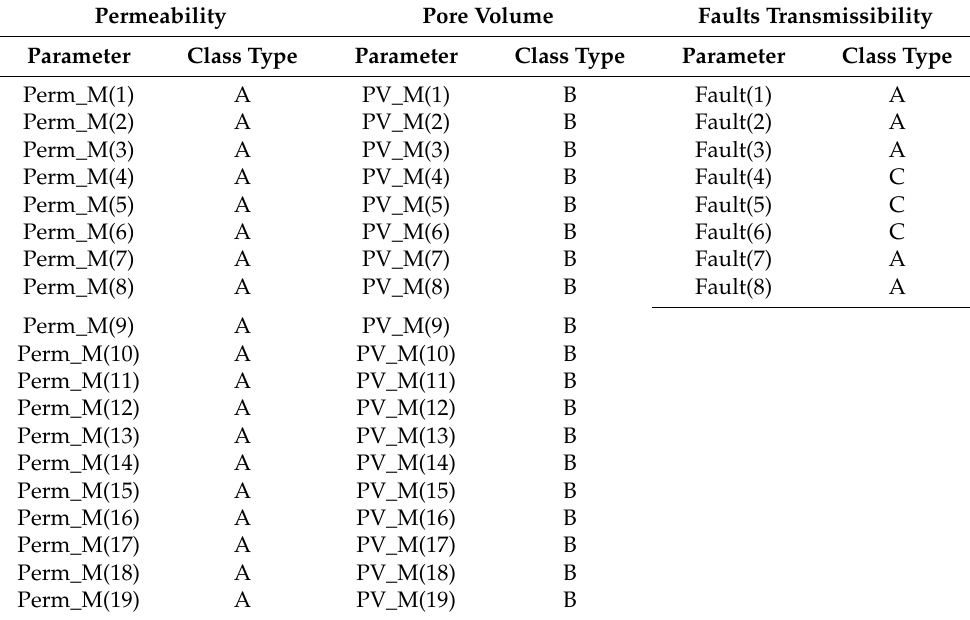
Table 5. The assignment of the history-matching parameters to